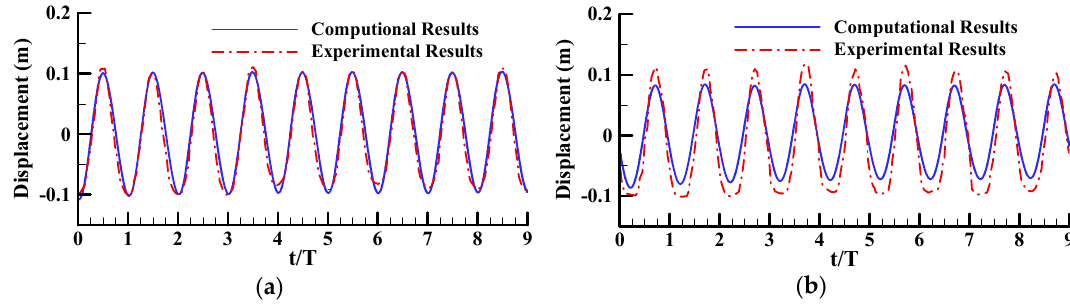
Figure 9. Comparison of time histories of buoy heaving motions: Experimental and numerical results. ( a ) Front Buoy; ( b ) Rear Buoy.